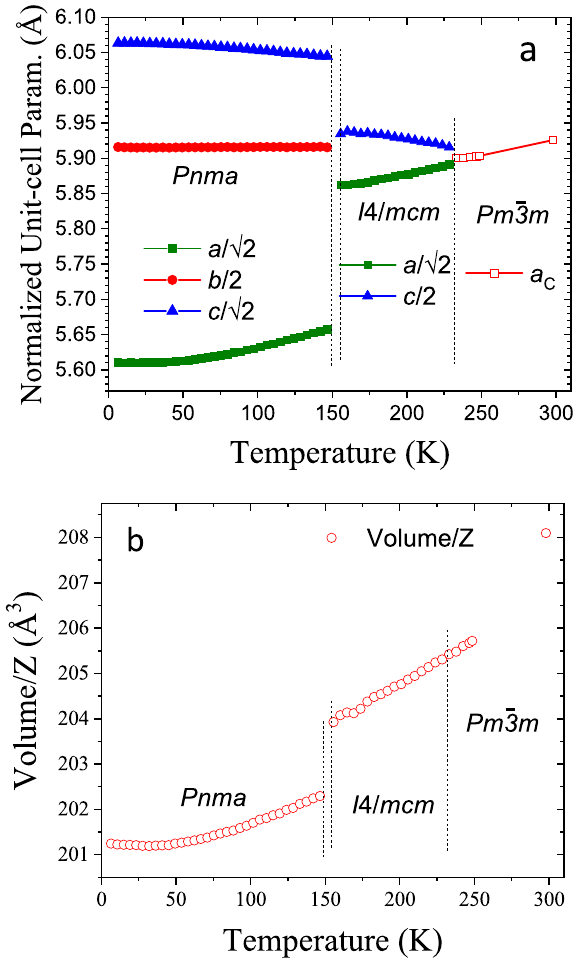
Figure 6. ( a ) Thermal evolution of a , b and c unit-cell parameters and ( b ) unit-cell volume of the orthorhombic phase.